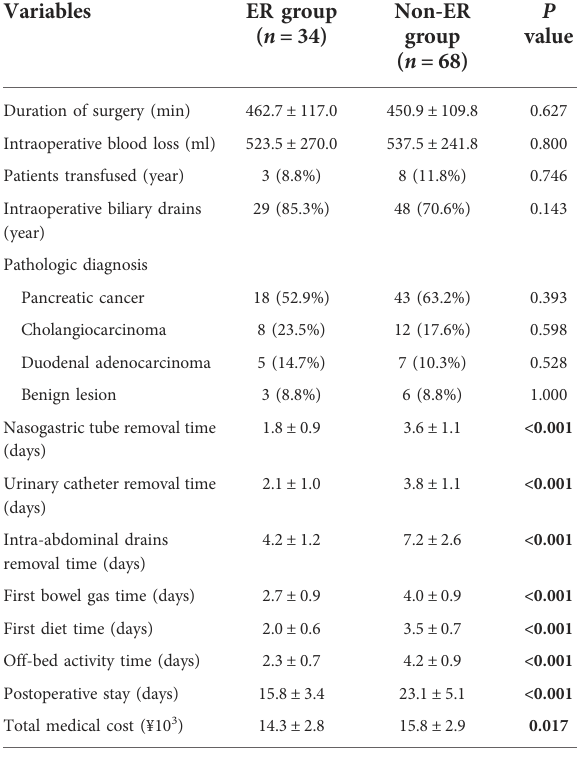
TABLE 3 Demographics and perioperative variables in patients. 17 perioperative variables were used to compare between two groups including duration of surgery, intraoperative blood loss, patients transfused, intraoperative biliary drains, pathologic diagnosis, pancreatic cancer, cholangiocarcinoma, duodenal adenocarcinoma, benign lesion, nasogastric tube removal time urinary catheter removal time, intra-abdominal drains removal time, fi rst bowel gas time, fi rst diet time, off-bed activity time, postoperative stay and total medical